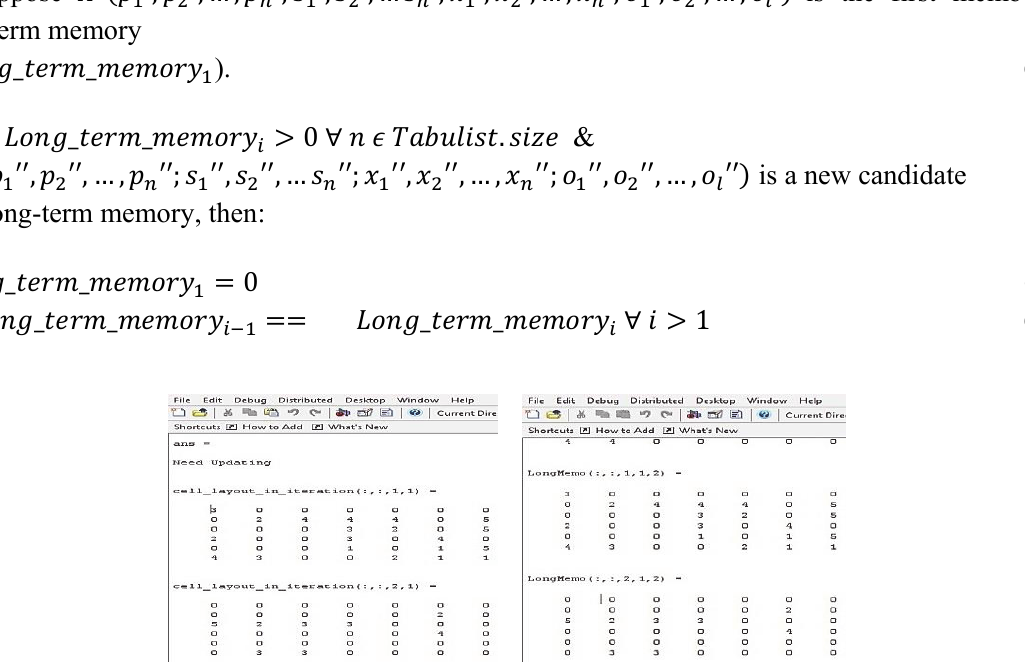
Fig. 4. Removing old member of long term memory (middle image)/ replacing it with the next member (right image)